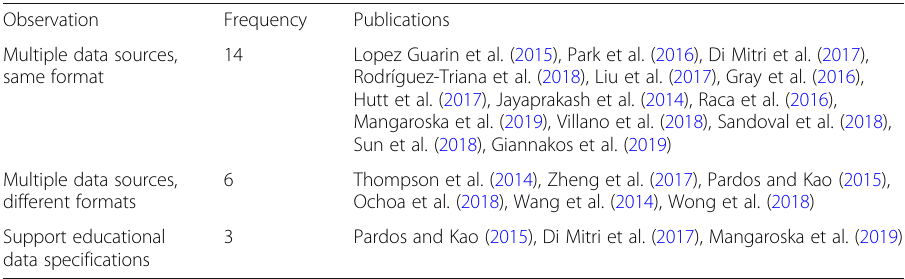
Table 4 Data sources and data integration